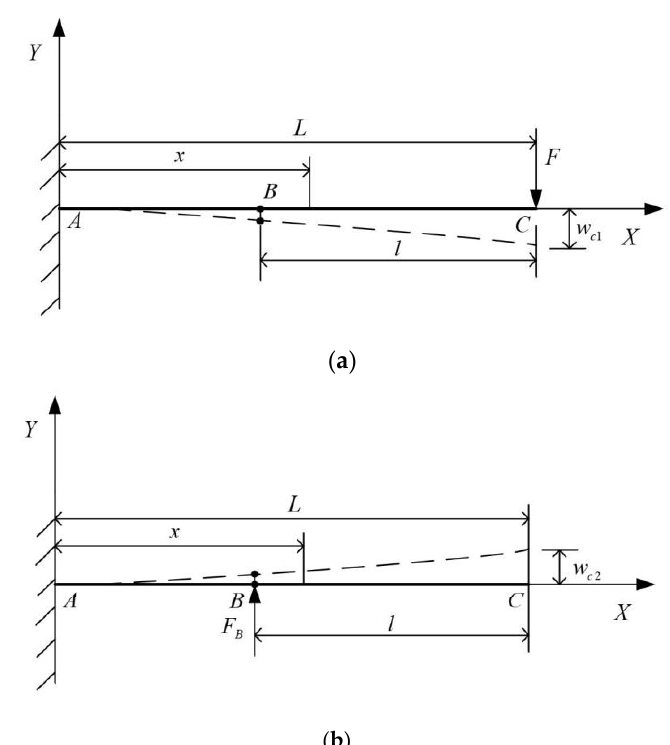
Figure 6. ( a ) The concentrated load is applied only at the rightmost end C of the cantilever beam. ( b ) Only a point B on the cantilever beam is subjected to concentrated load.